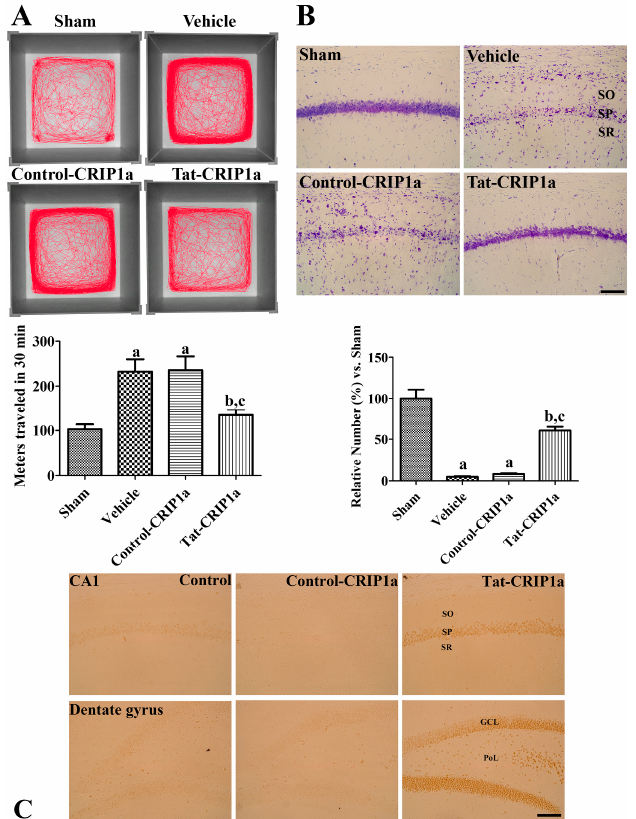
Figure 4. In vivo neuroprotective effects of Control-CRIP1a and Tat-CRIP1a proteins against ischemic damage in gerbils. ( A ) Images showing track visualization for 30 min in each groups 1 day after ischemia. ( B ) Cresyl violet staining in the hippocampal CA1 region of the sham, vehicle, Control-CRIP1a, and Tat-CRIP1a groups at 4 days after ischemia reperfusion. ( C ) Confirmation of penetrated Tat-CRIP1a into neurons in the SP, GCL and PoL in the Tat-CRIP1a group using anti-histidine antibody. A single injection of His-CRIP1a or Tat-His-CRIP1a was administered intraperitoneally to the animals, and they were sacrificed 8 h after administration. Scale bar = 100 μ m. SO, stratum oriens; SP, stratum pyramidale; SR, stratum radiatum; GCL, granule cell layer; PoL, polymorphic layer. Meters moved in 30 min, described as mean values, and the number of cresyl violet-positive cells are shown as a percentage of the value of the sham group. A one-way ANOVA test was used to analyze the data followed by Bonferroni’s post-hoc test ( n = 5 per group; a p < 0.05, significantly di ff erent from the control group; b p < 0.05, significantly di ff erent from the vehicle group; c p < 0.05, significantly di ff erent from the Control-CRIP1a group). Data are expressed as mean with standard